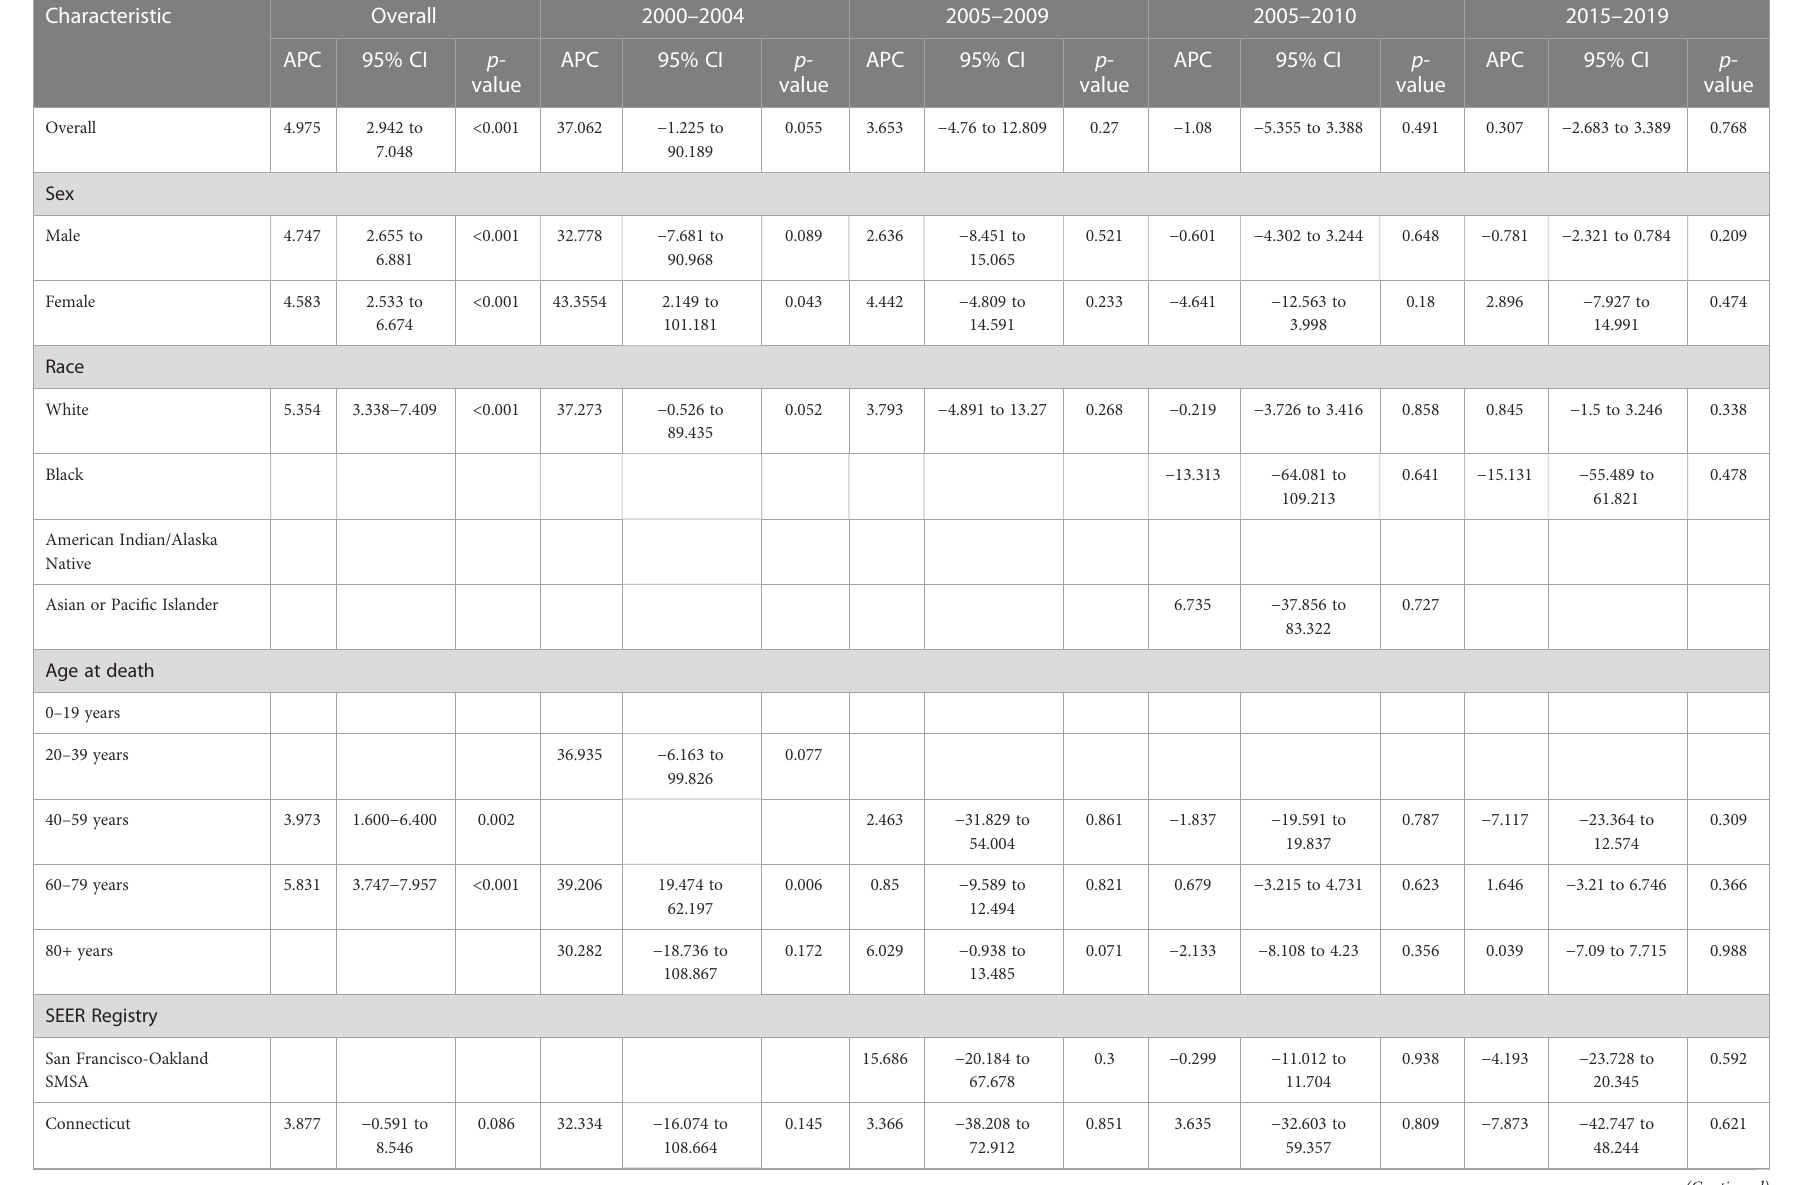
TABLE 3 Trends in cSCC on the lip incidence-based mortality rates (2000 – 2019): The SEER-17 registry database.